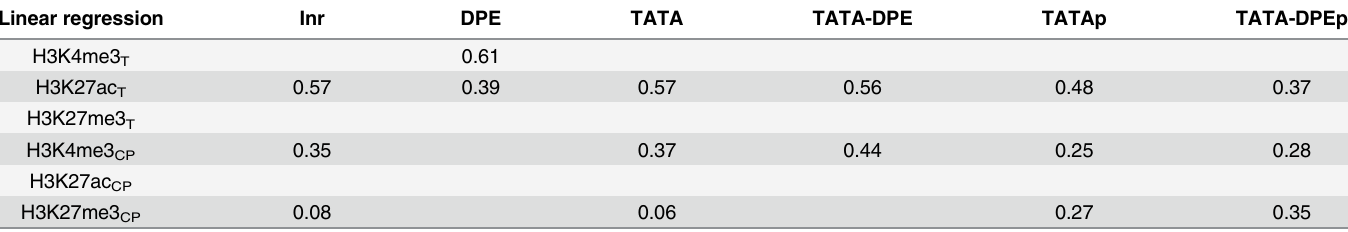
Table 1. The relative importance of each histone modification in determining RNA expression levels was calculated using the regression equa- tions obtained by linear regression analysis using the LMG method [12]. Values were normalized such that the sum of all values was 1. Linear regression Inr DPE